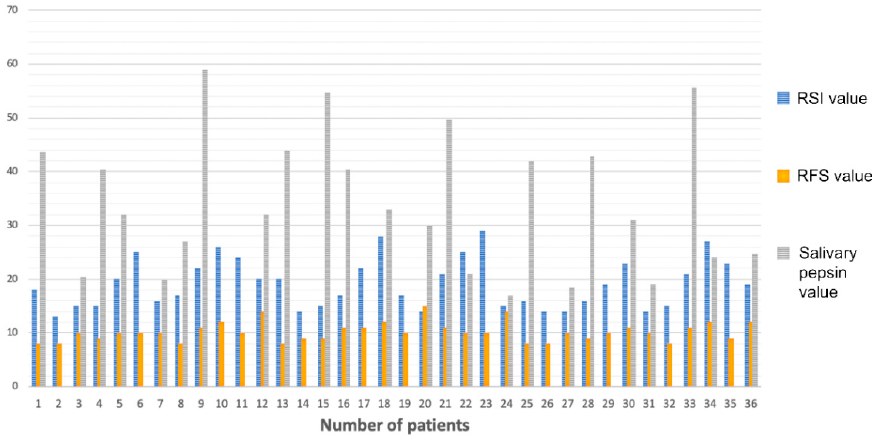
Figure 3. Histogram: Patients positive in reflux symptom index (RSI) (blue column), reflux finding score RFS (yellow column), and PEP-test (gray column) evaluations. Patients with only RSI and RFS columns were those that showed positivity to clinical investigation but negativity for salivary pepsin presence (negative PEP-test).